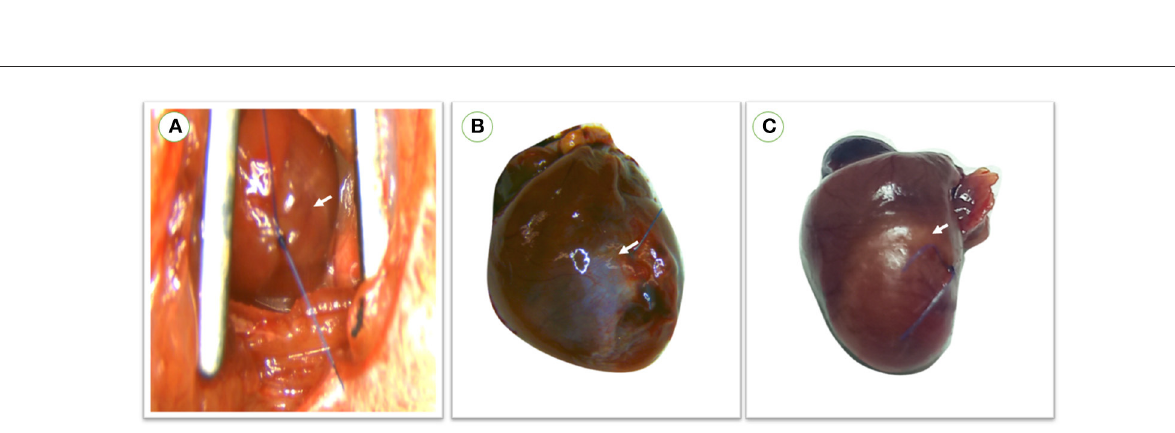
complete, and stable anesthetic effect than intraperitoneal injection (23). The intraperitoneal delivery route is the